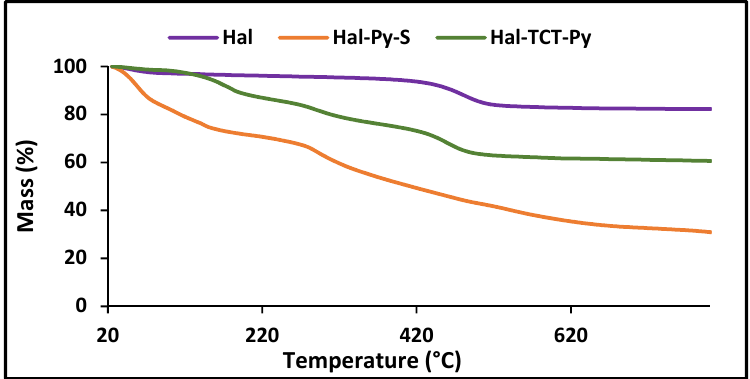
Figure 7 . TG thermograms of Hal, Hal-TCT-Py, Hal-Py-IL. Figure 7. TG thermograms of Hal, Hal-TCT-Py,